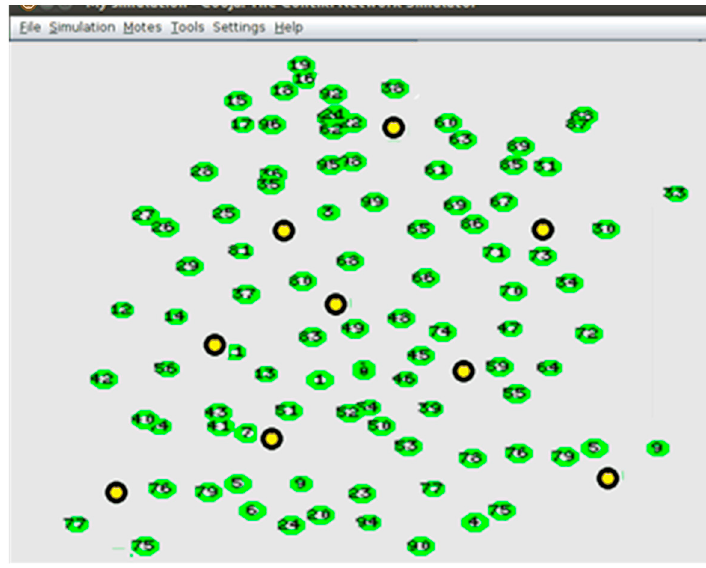
Figure 7. Simulation WSN nodes.